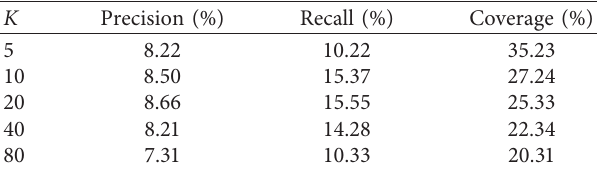
Table 3: User collaborative filtering under different K values based on cosine similarity.